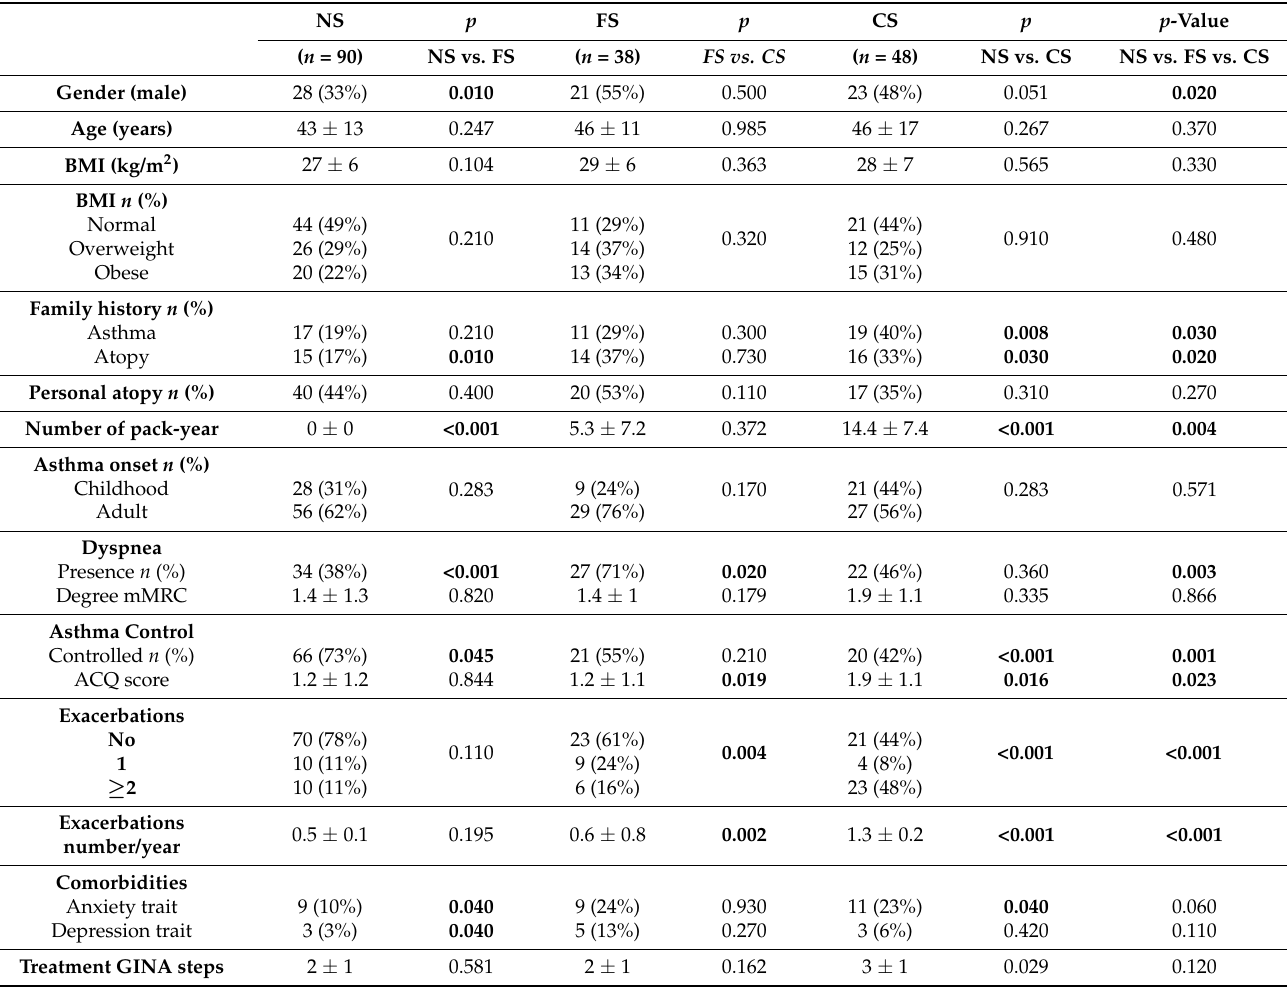
Table 1. Clinical characteristics of subjects according to smoking